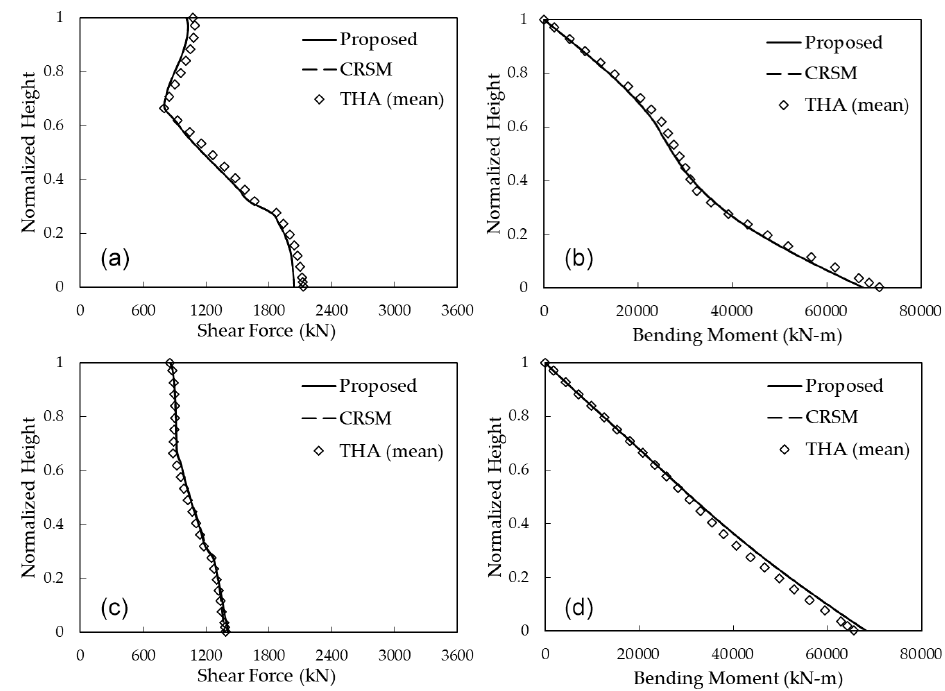
Figure 5. Mean profiles of seismic loadings on the tower: (a) shear force for Soil type I, (b) bending moment for Soil type I, (c) shear force for Soil type II, and (d) bending moment for Soil type II.